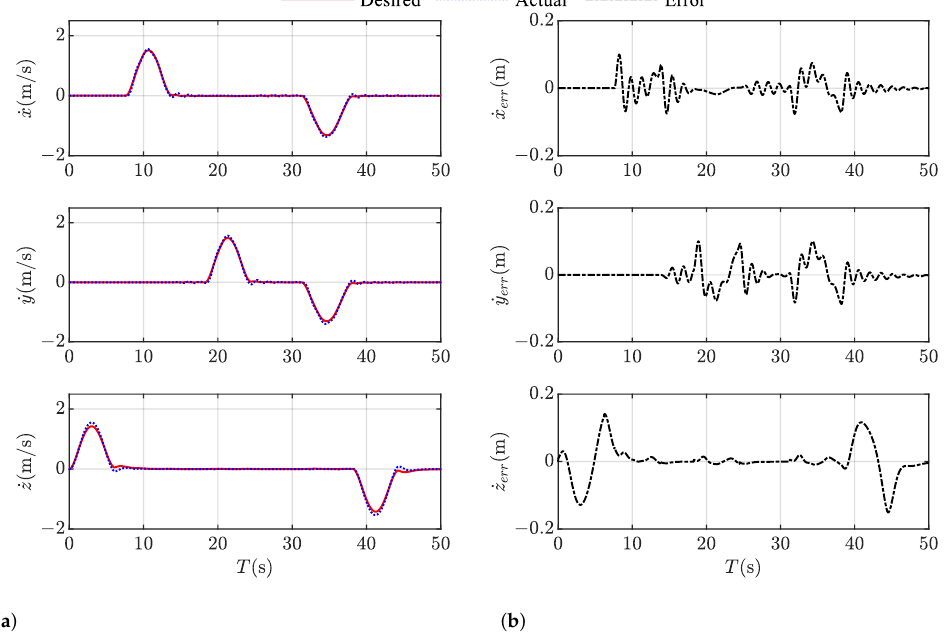
Figure 11. Velocity tracking in the simulation: ( a ) velocity tracking response; ( b ) velocity tracking